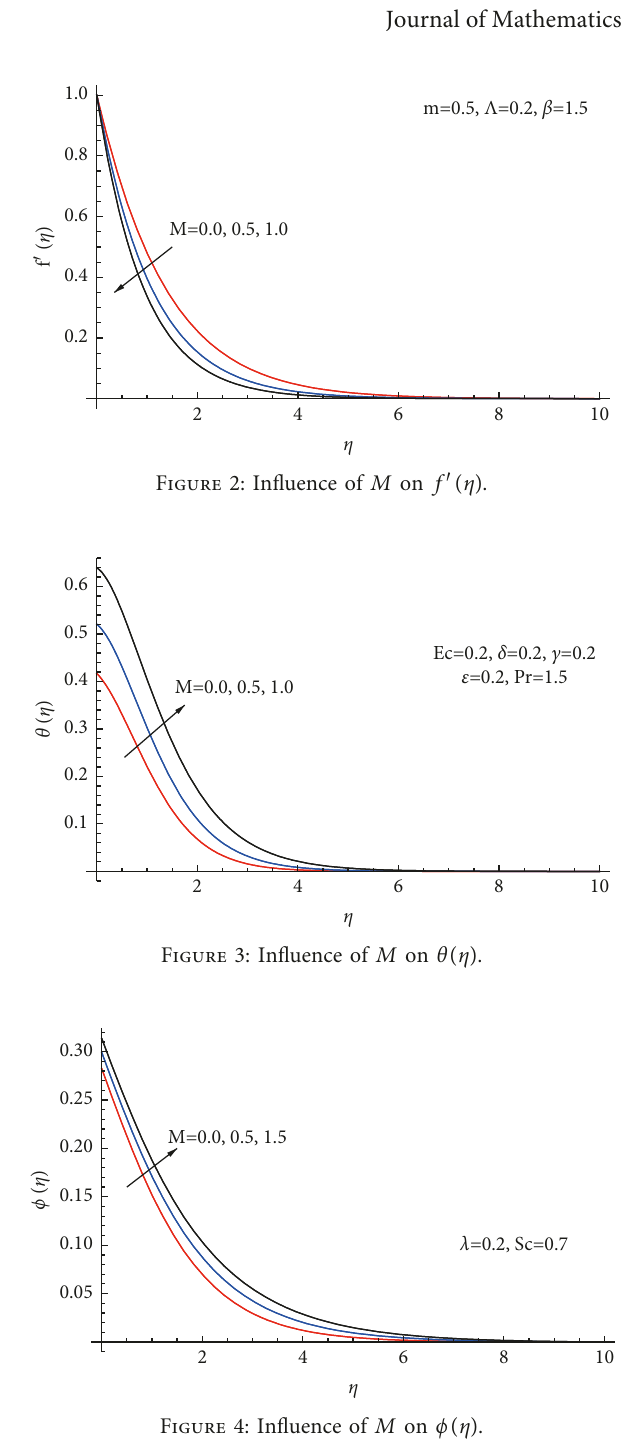
Figure 4: Influence of M on ϕ ( η )